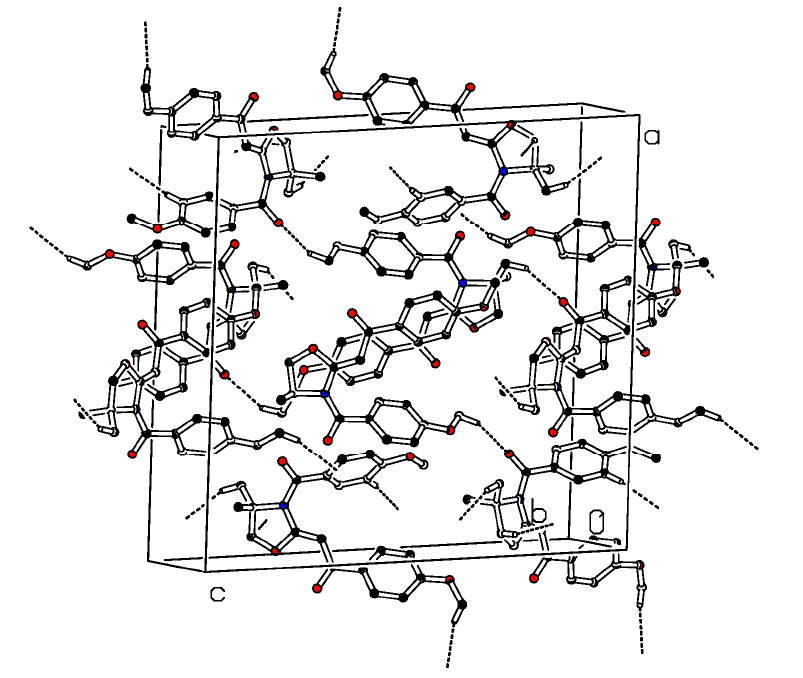
Figure 3. A crystal packing diagram for compound 4